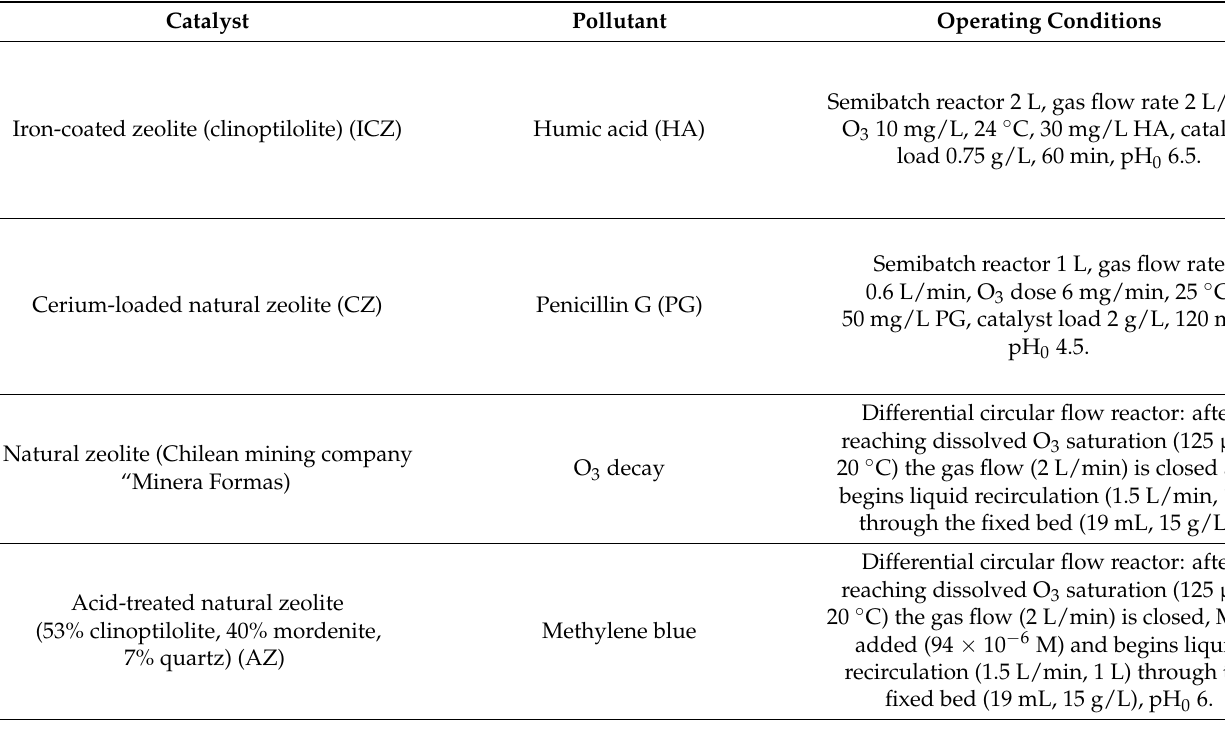
Table 2. Natural zeolites as catalysts in the ozonation of organic